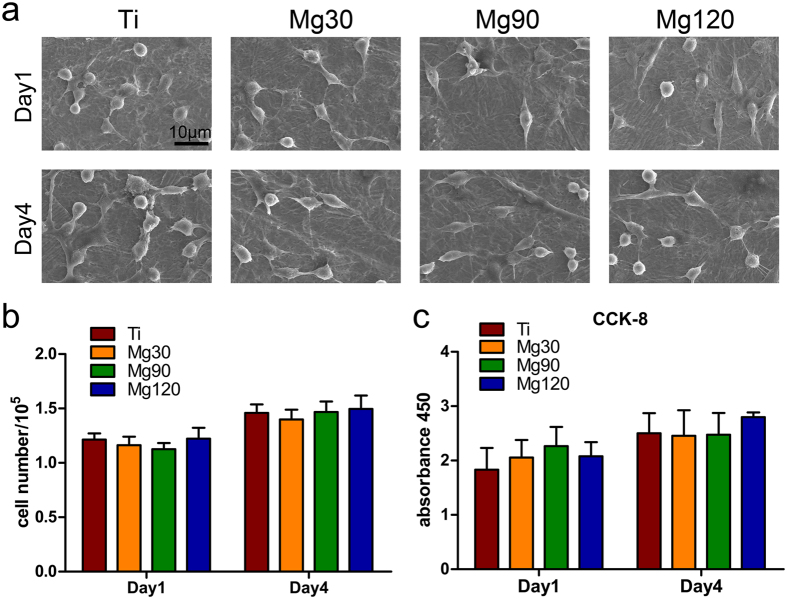
(a) Morphology of RAW 264.7 cells on various surfaces, as determined by SEM at day 1 and day 4, (b) RAW 264.7 cell number on the surface, (c) Cell proliferation evaluated with a Cell Counting Kit-8 (CCK-8). (Statistically significant difference: *p < 0.05; **p < 0.01; triplicate).